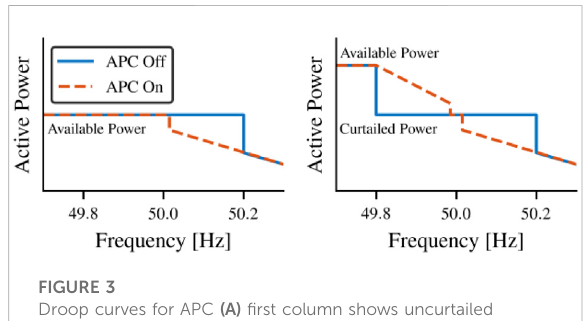
FIGURE 3 Droop curves for APC (A) fi rst column shows uncurtailed wind (B) second column shows wind when it is